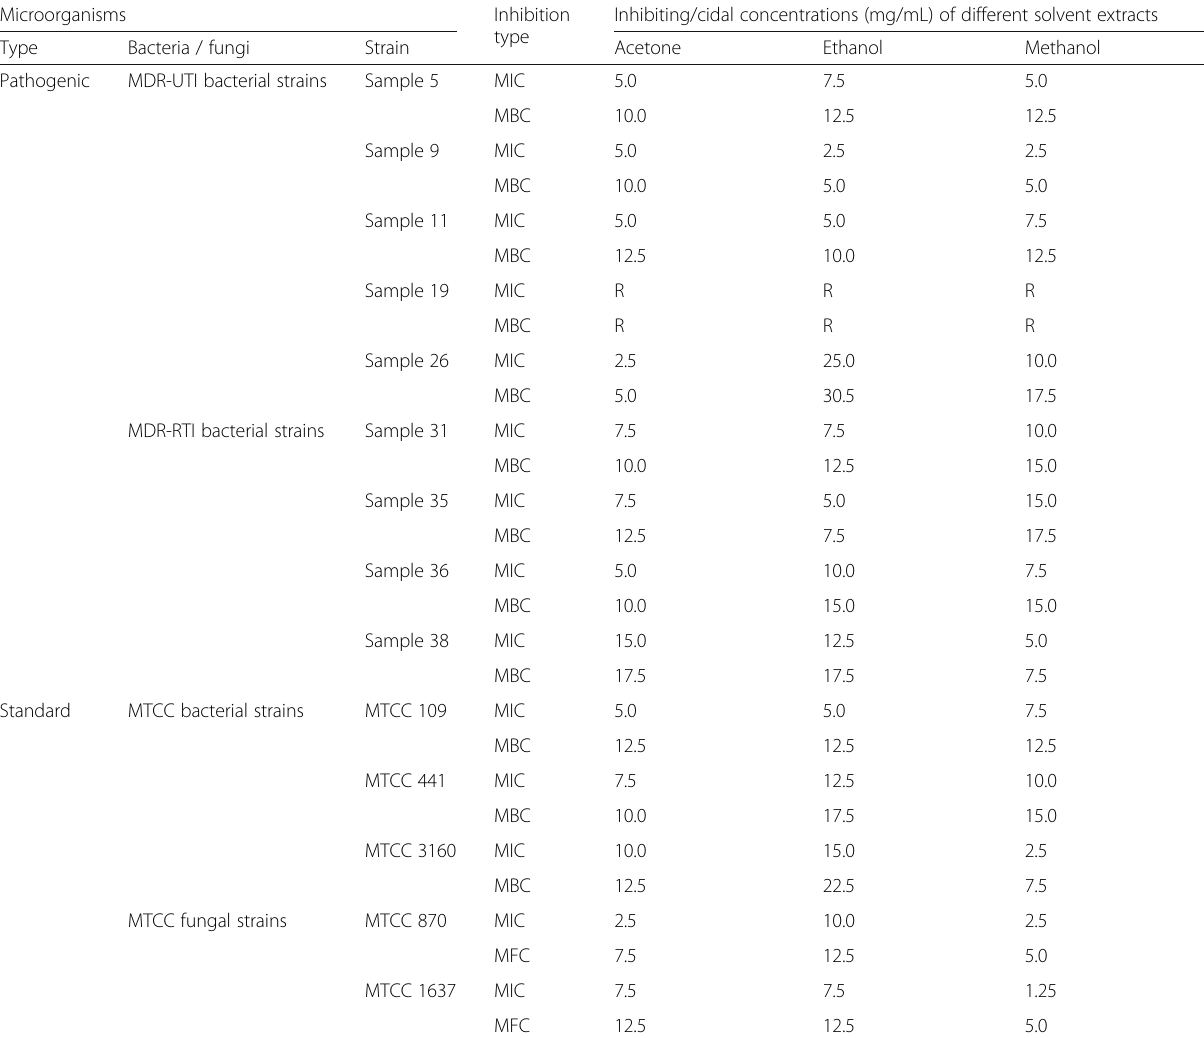
Inhibiting/cidal concentrations (mg/mL) of different solvent extracts type